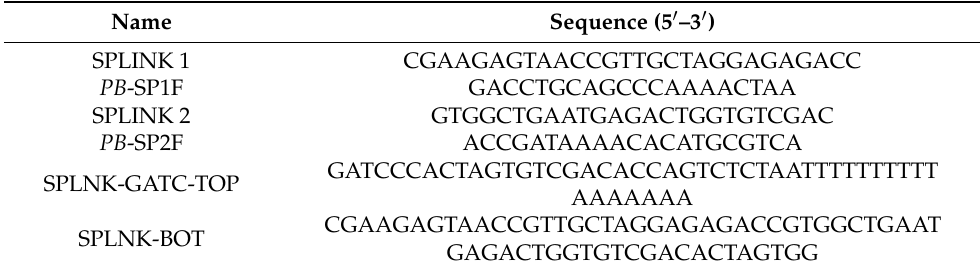
Table 2. SP-PCR primers and linker